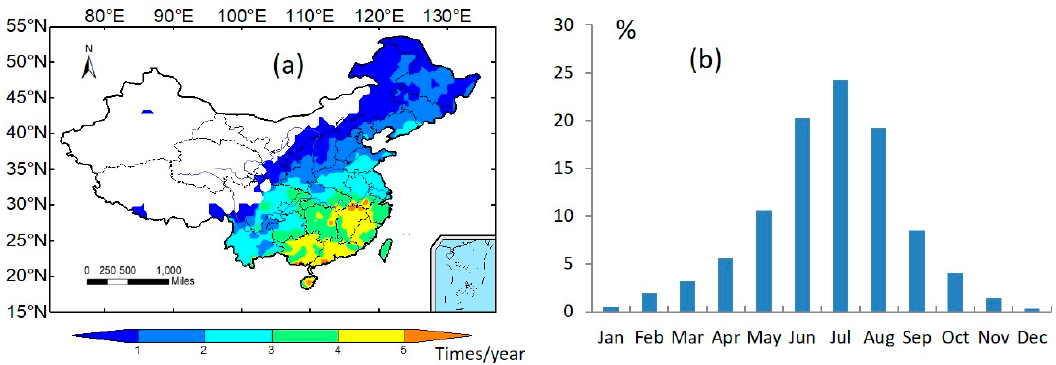
Figure 3. Frequency of flood-causing HRPs (( a ), units: times/year) and their seasonal characteristics (( b ), units: %).